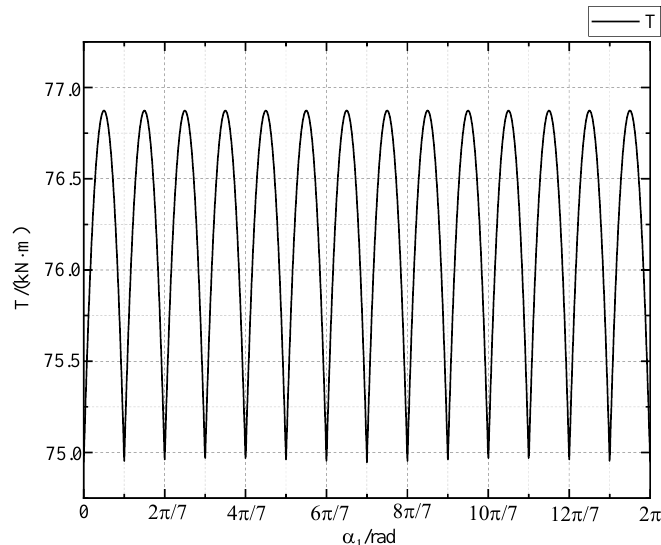
Figure 5. Diagram of the crankshaft driving torque.